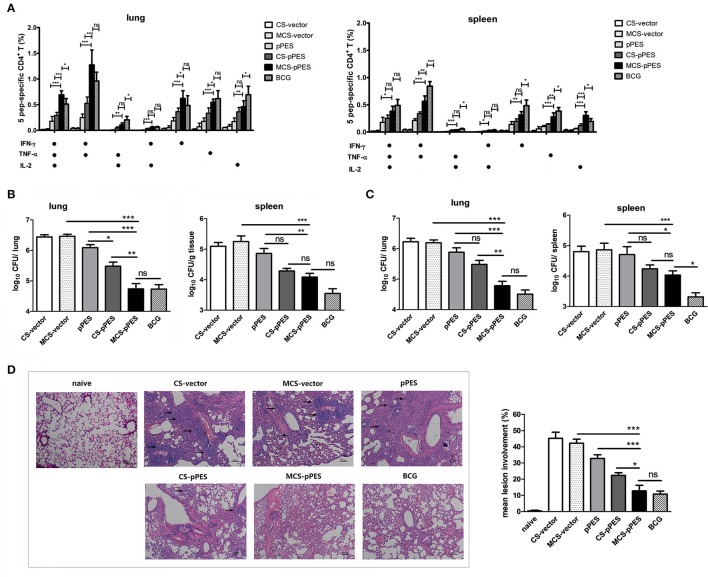
Post-challenge T response and protection against Mycobacterium bovis BCG challenge by MCS-pPES immunization. Vaccinated mice were challenged i.n. with 1 × 107 CFU of M. bovis BCG. (A) 4 weeks post-challenge, the peptide-specific poly-functional CD4+Th1 responses in the lungs or spleens were defined as the number of cells expressing any combination of IFN-γ, TNF-α or IL-2. The average percentages for each subset are shown. Results are represented as mean ± SEM (n = 3) of three separate experiments. (B,C) Bacterial load within the lungs and spleens of mice 4 weeks (B) and 8 weeks (C) post-challenge with BCG. Results are presented as log10CFU within each organ. Data are expressed as mean ± SEM from pooled three separate experiments (n = 6). *p < 0.05; **p < 0.01; ***p < 0.001; ns, not significant. (D) Representative lung pathology of mice by H&E staining 4 weeks after challenge, showing the immune infiltration and granuloma-like pathology in the lung (denoted by black arrows). One representative image of each group of three separate experiments was shown (magnification: × 100). Inflammation lesion involvement within the lungs of mice was summarized. Data are represented as mean ± SEM (n = 5). Three separate experiments were repeated and one result was shown.